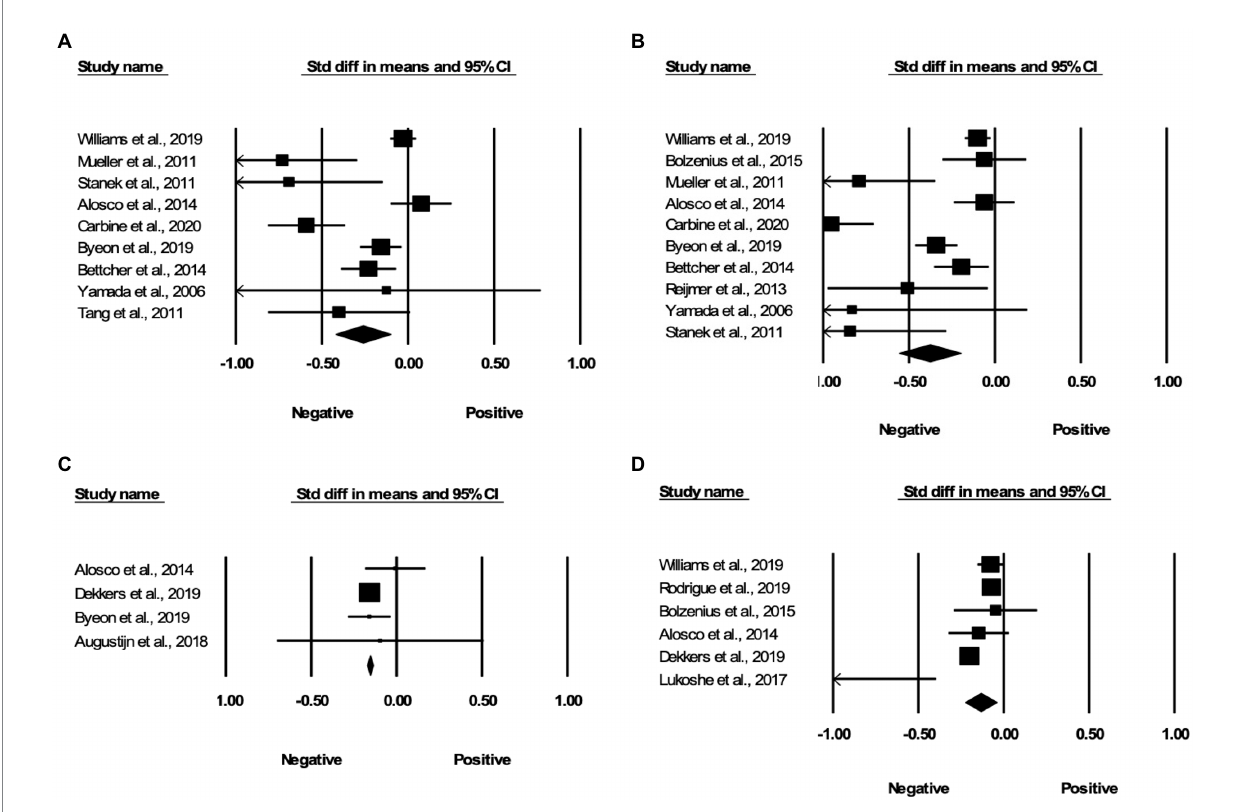
FIGURE 3 Associations between obesity and FA in the region of interest effect size meta-analyses. Forest plots of the significant findings from the effect size meta-analysis within the regions of (A) genu of the corpus callosum, (B) splenium of the corpus callosum, (C) middle cerebellar peduncles, and (D) superior longitudinal